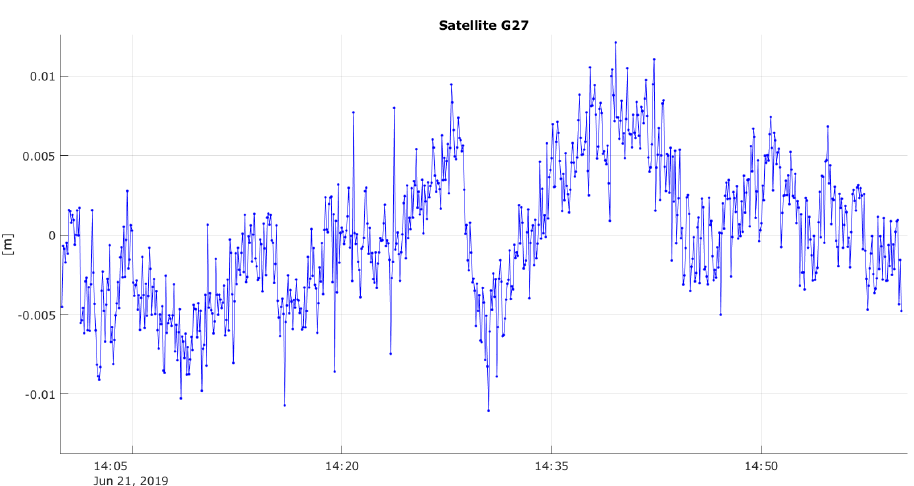
Figure 2. The difference of geometry-free combination between two closed GNSS stations after subtracting the average. GNSS receivers are